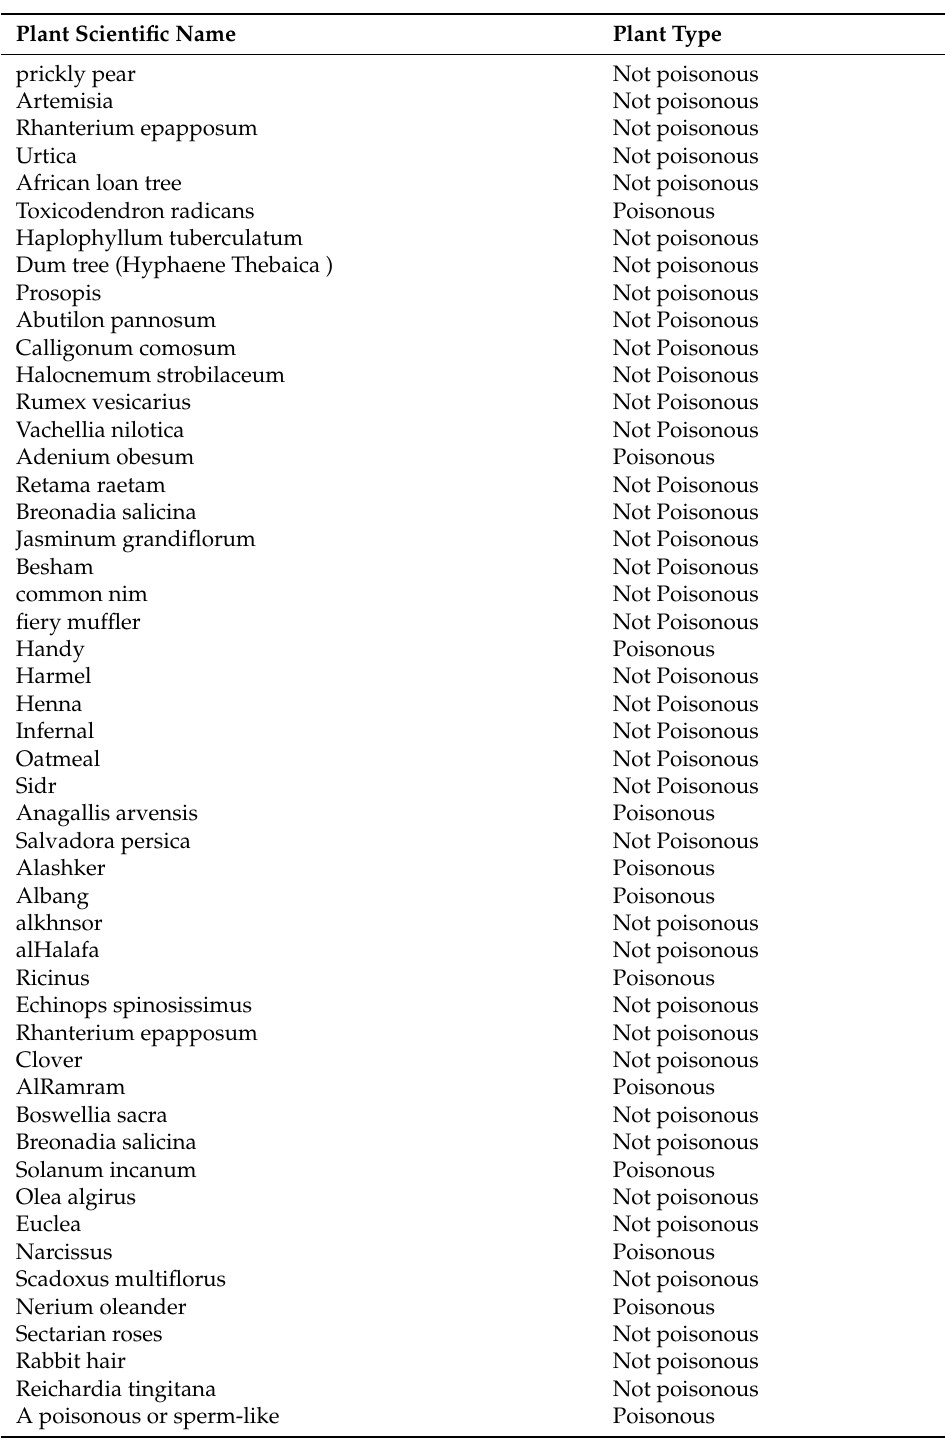
Table 1. Type of Arabic plants: selected 50 various